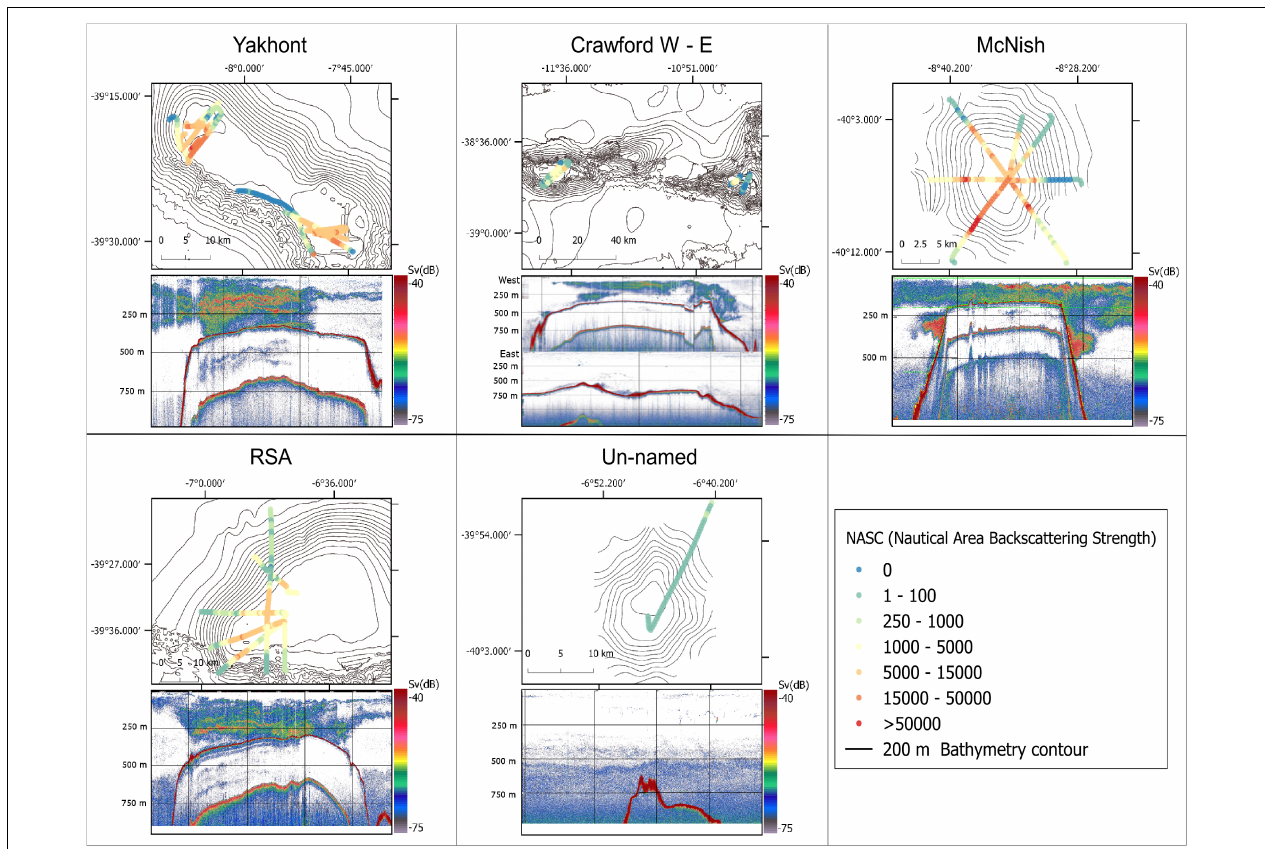
FIGURE 3 | Maps of the Nautical Area Backscattering Coefficient (NASC) at 70 kHz for all the Tristan da Cunha seamounts. An example echogram (Sv, volume backscattering strength) representing one full transect of the corresponding seamount, is shown at the bottom of each panel. The vertical and horizontal black lines on the echograms are 2.5 nautical miles and 250 m spaced,